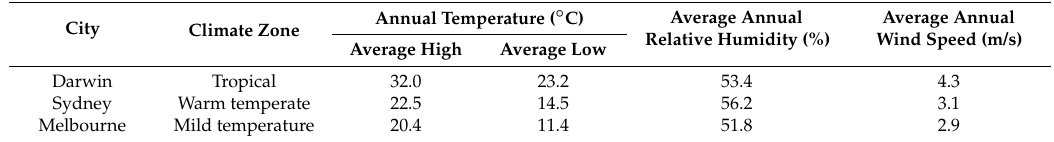
Figure 1. Australian climate zones [25]. Reproduced with permission from Australian Bureau of Statistics, Year Book Australia, 2012; published by ABS Canberra: Canberra, Australia, 2012 Since the majority of Australia’s population lives in coastal instead of central areas (dry and desert regions), three coastal cities, Darwin, Sydney and Melbourne, were selected to represent the three most populous climate zones. Darwin is the capital of the Northern Territory located in the hot humid summer, warm winter zone with a tropical climate. The coldest month’s average air temperature is 20 °C. The hottest monthly average air temperature is 32 °C. Sydney is the capital of the State of New South Wales, located in the mild temperate zone with a humid subtropical monsoon climate. The coldest month’s average air temperature is 17.2 °C. The hottest monthly average air temperature is 36.4 °C. Melbourne is the capital of the State of Victoria, located in the cool temperate zone with a temperate marine climate. The climate details of the three cities are illustrated in Error! Reference source not found. Table 1. Climatic characteristics of the representative cities [25].